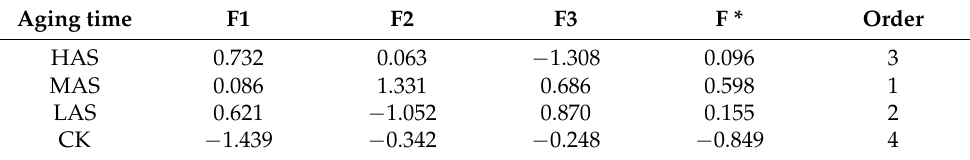
Table 5. Overall scores of principal components after